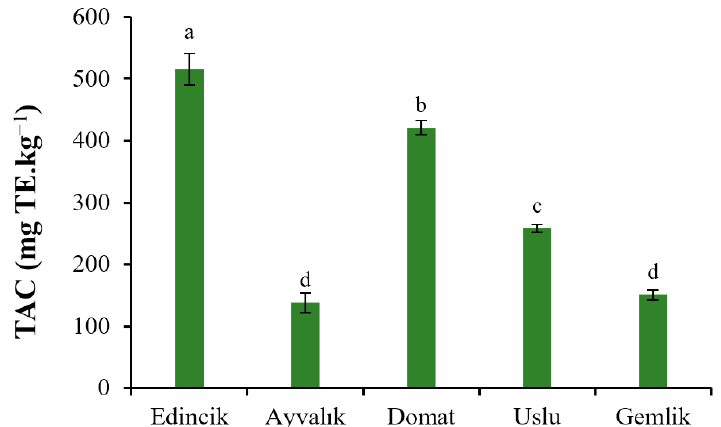
Figure 1. TAC of EVOOs from five Turkish olive cultivars. Different letters on the bars indicate significant differences between different oil samples ( p < 0.05). significant differences between different oil samples ( p <